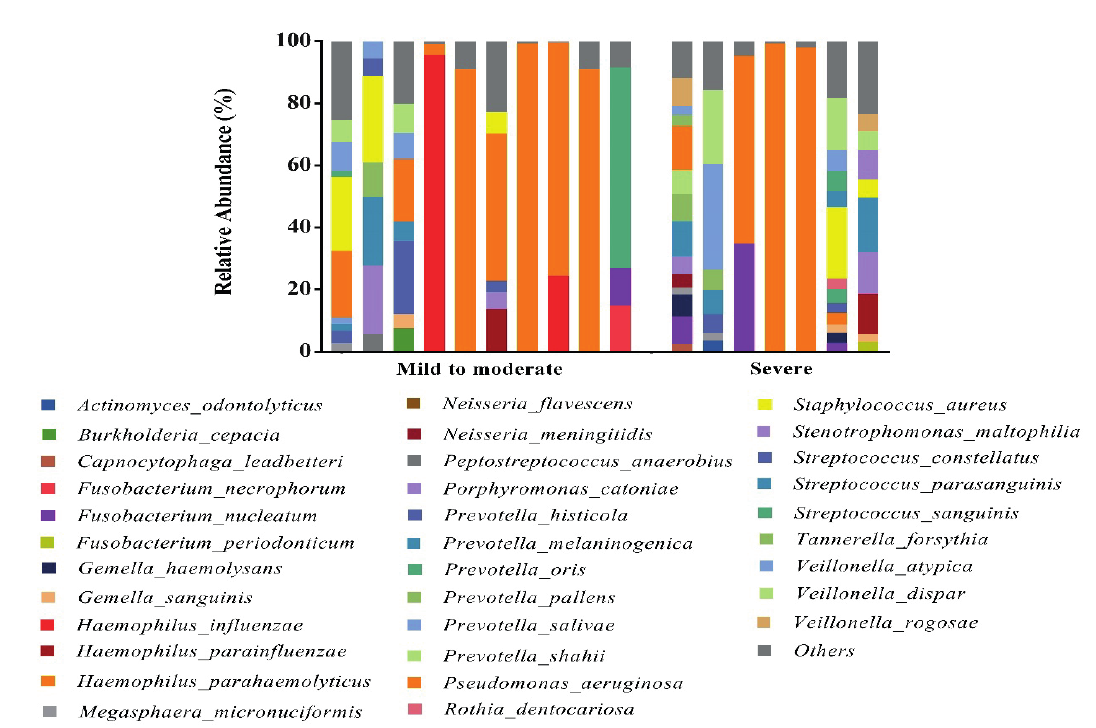
Figure S4. Main bacterial species found in sputum samples in each patient. Pseudomonas aeruginosa were present in 80% of sample of mild/moderate lung disease and in 57% of samples of severe